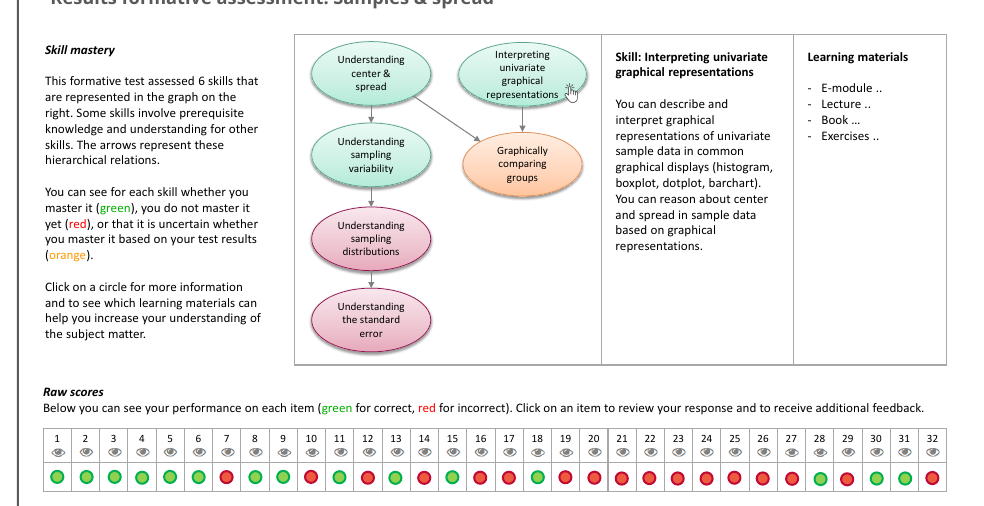
Figure 2. Mock-up student dashboard to report cognitive diagnostic assessment